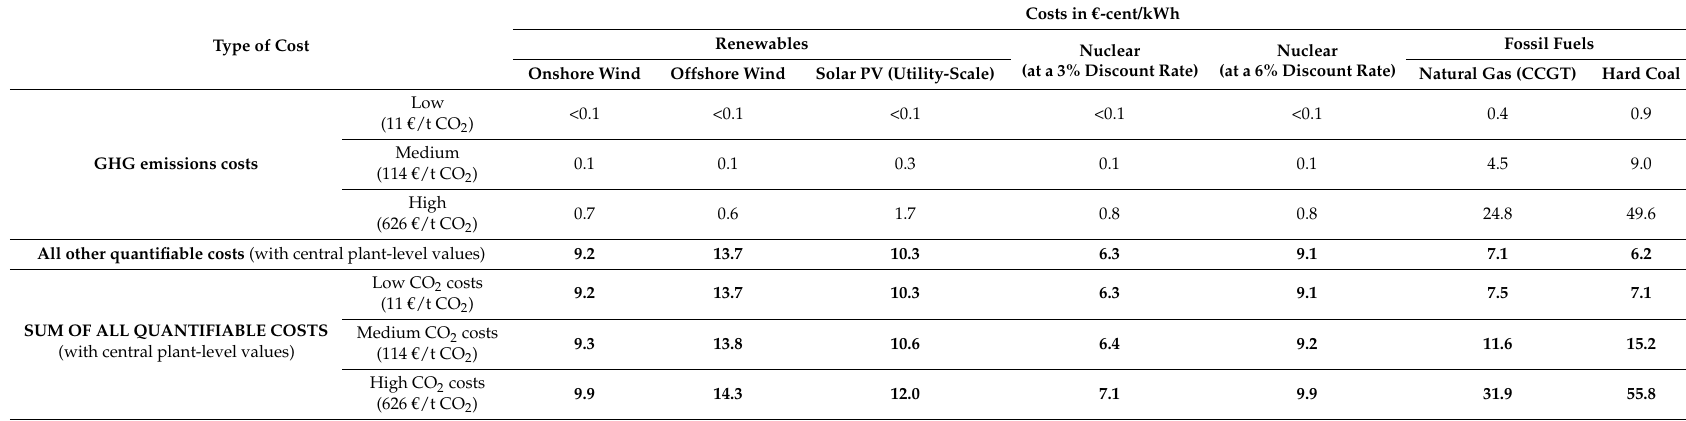
Table 13. Overview of the estimated specific social costs of electricity generation in Europe from several types of power plants assumed to start operating in 2040. Type of Cost Sum of plant-level costs (w/o CO 2 costs) (central values; ranges in parenthesis)